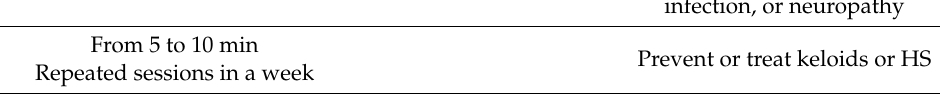
Table 10. Summary of the practical protocols reviewed in ultrasound therapy (UT) in wound healing (WH). Modality Type of Wound Not yet Studied/Not Beneficial LFU Around the wound From 5 to 10 min Repeated sessions in a week After 2–5 days of the